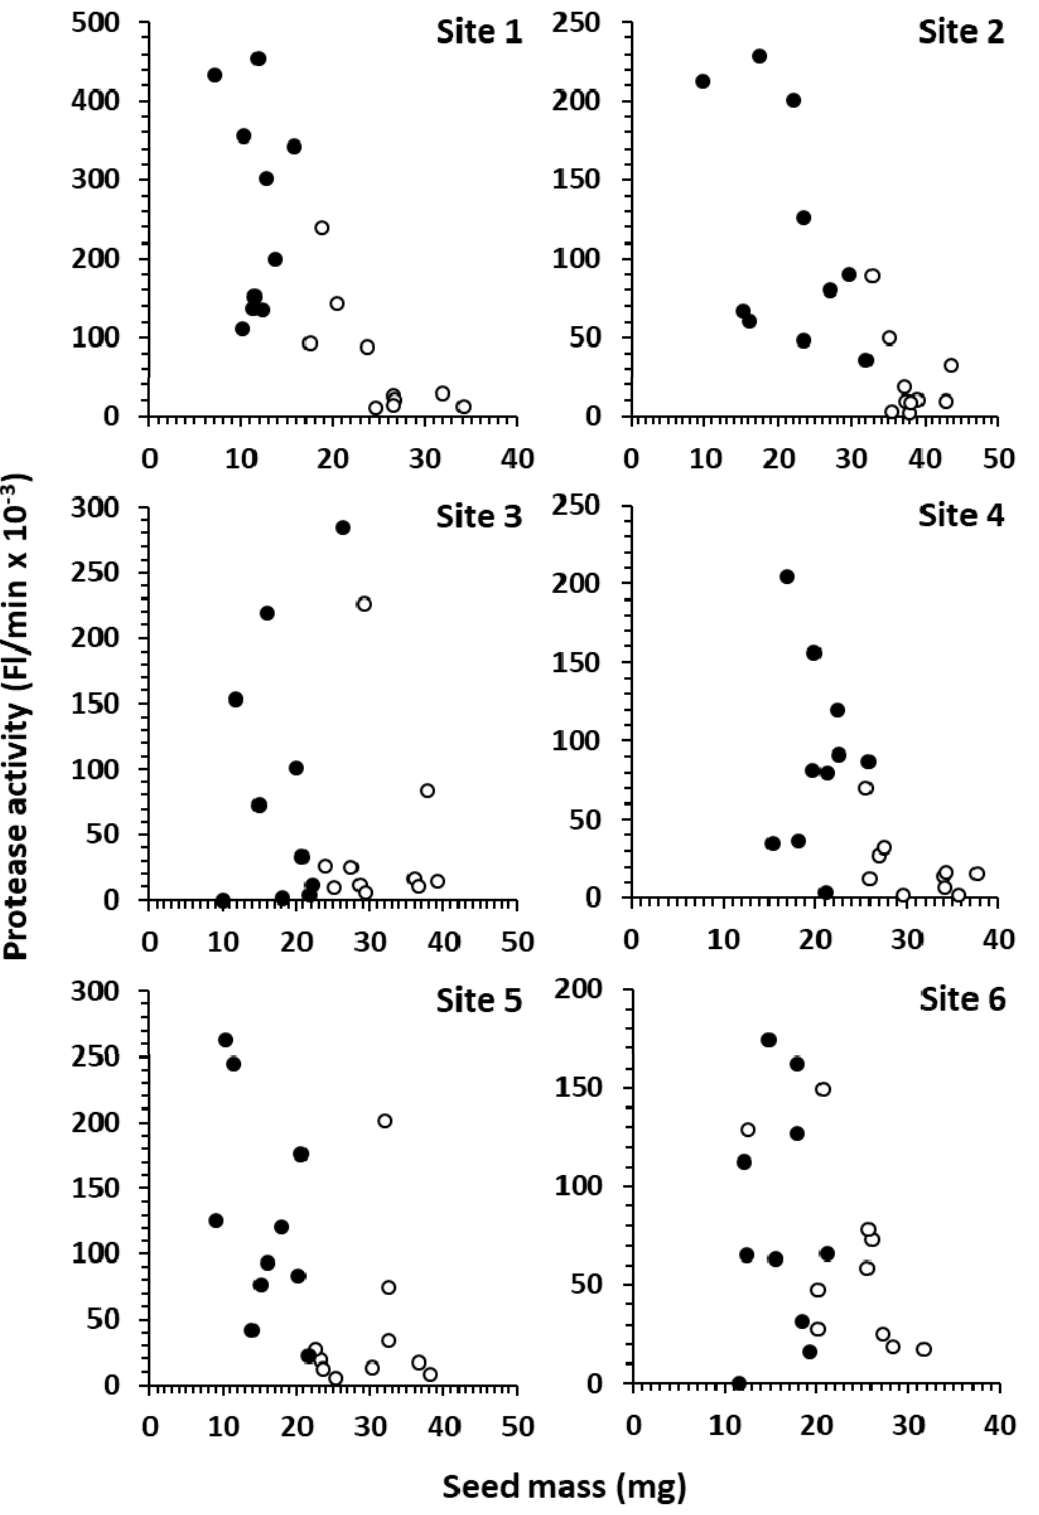
Figure 4. Protease activity from single affected ( ○ ) or distorted ( ● ) FDK kernels in samples from six sites across Western Canada relative to seed mass. Activity varies widely between sites and among affected and distorted FDK.